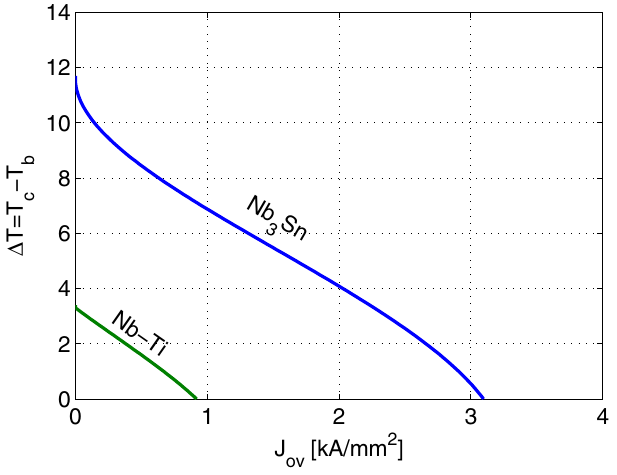
FIG. 7. (Color) Temperature margin versus overall critical cur- rent density for Nb-Ti and Nb Sn in a 9 T 3